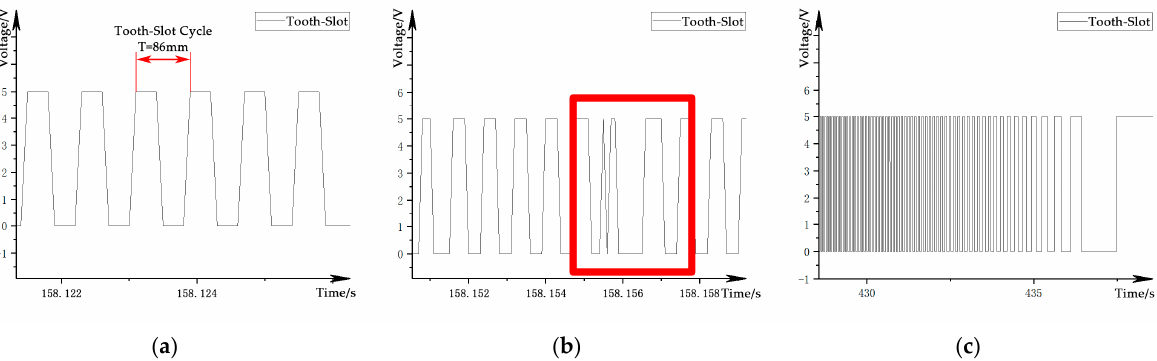
Figure 5. Waveform of the tooth-slot signal: ( a ) ideal signal; ( b ) structure-affected signal; ( c ) speed-affected signal.